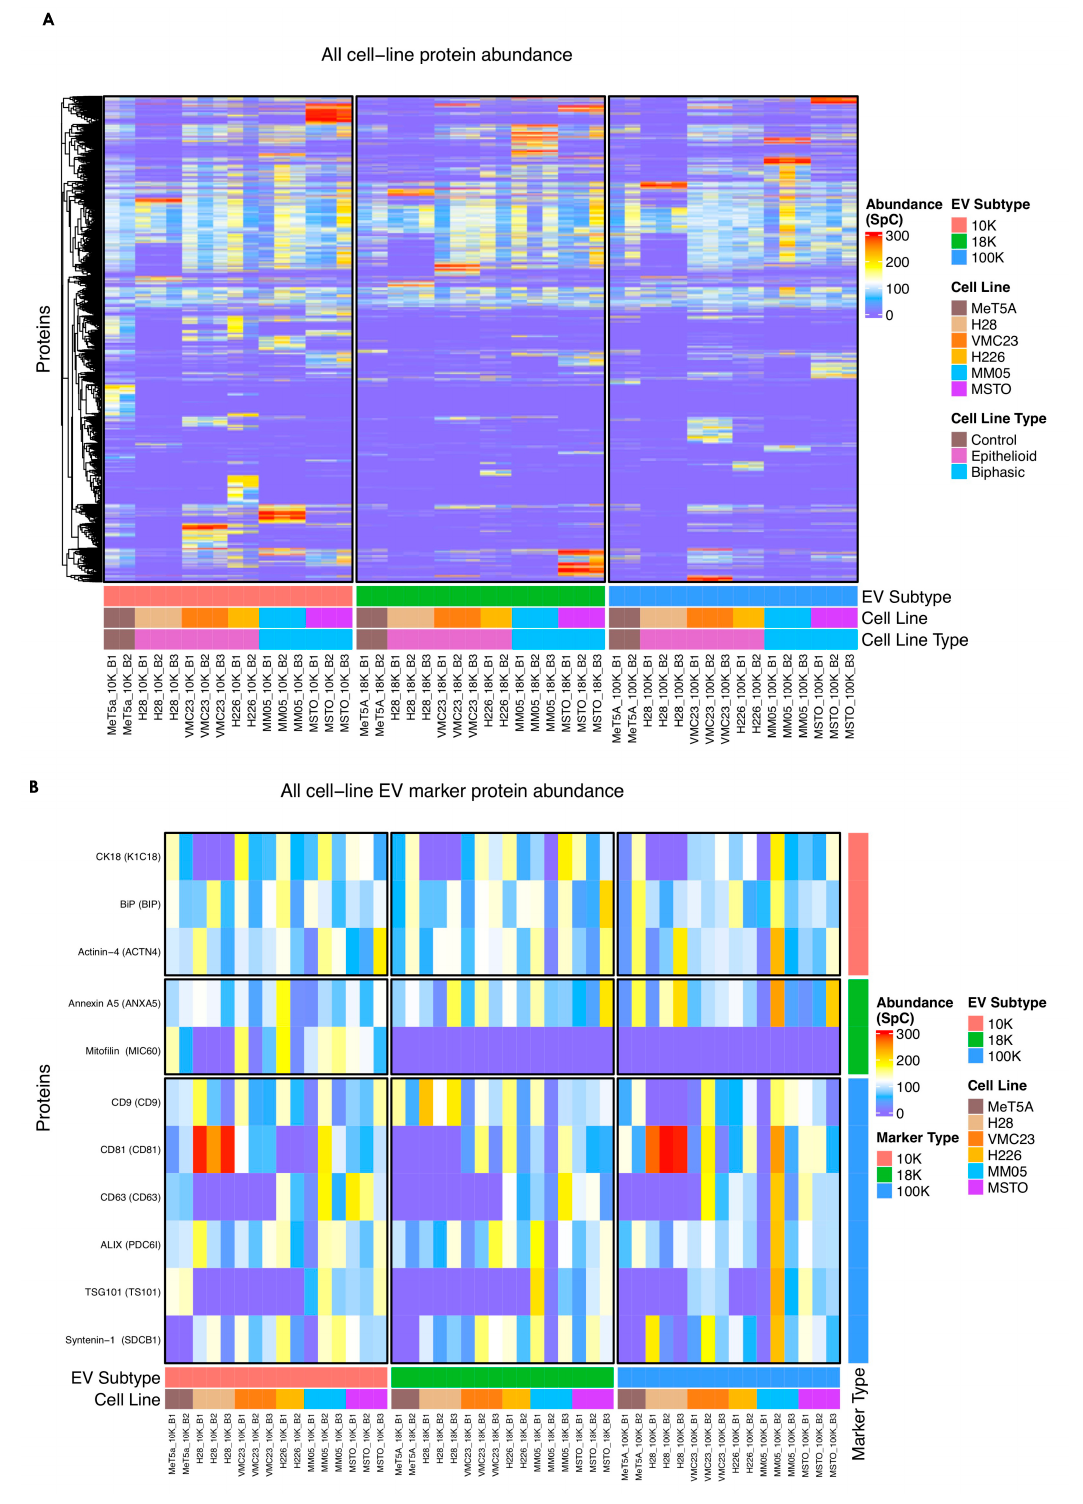
Figure 6. Heatmap representing the differential abundance based on normal spectral count (SpC). ( A ) Heatmap of differentially expressed proteins across all samples, including their biological and technical replicates, showing similarities and differences between each of the EVs derived from pleural mesothelioma cell lines. ( B ) Heatmap focusing on the differential expression of common EV markers across each of the EV subtypes derived from pleural mesothelioma cell lines. Data obtained from four biological replicates. Protein abundance values represent the sum of all unique peptides for a specific